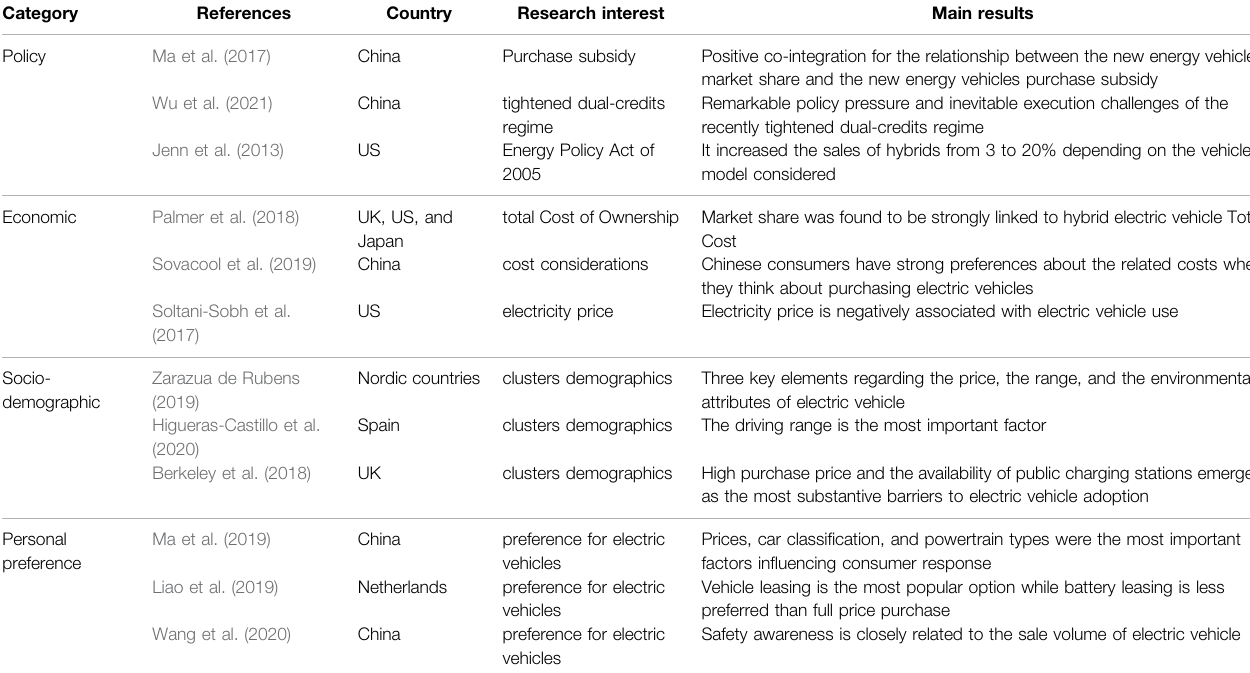
TABLE 1 | Literature on factors affecting new energy